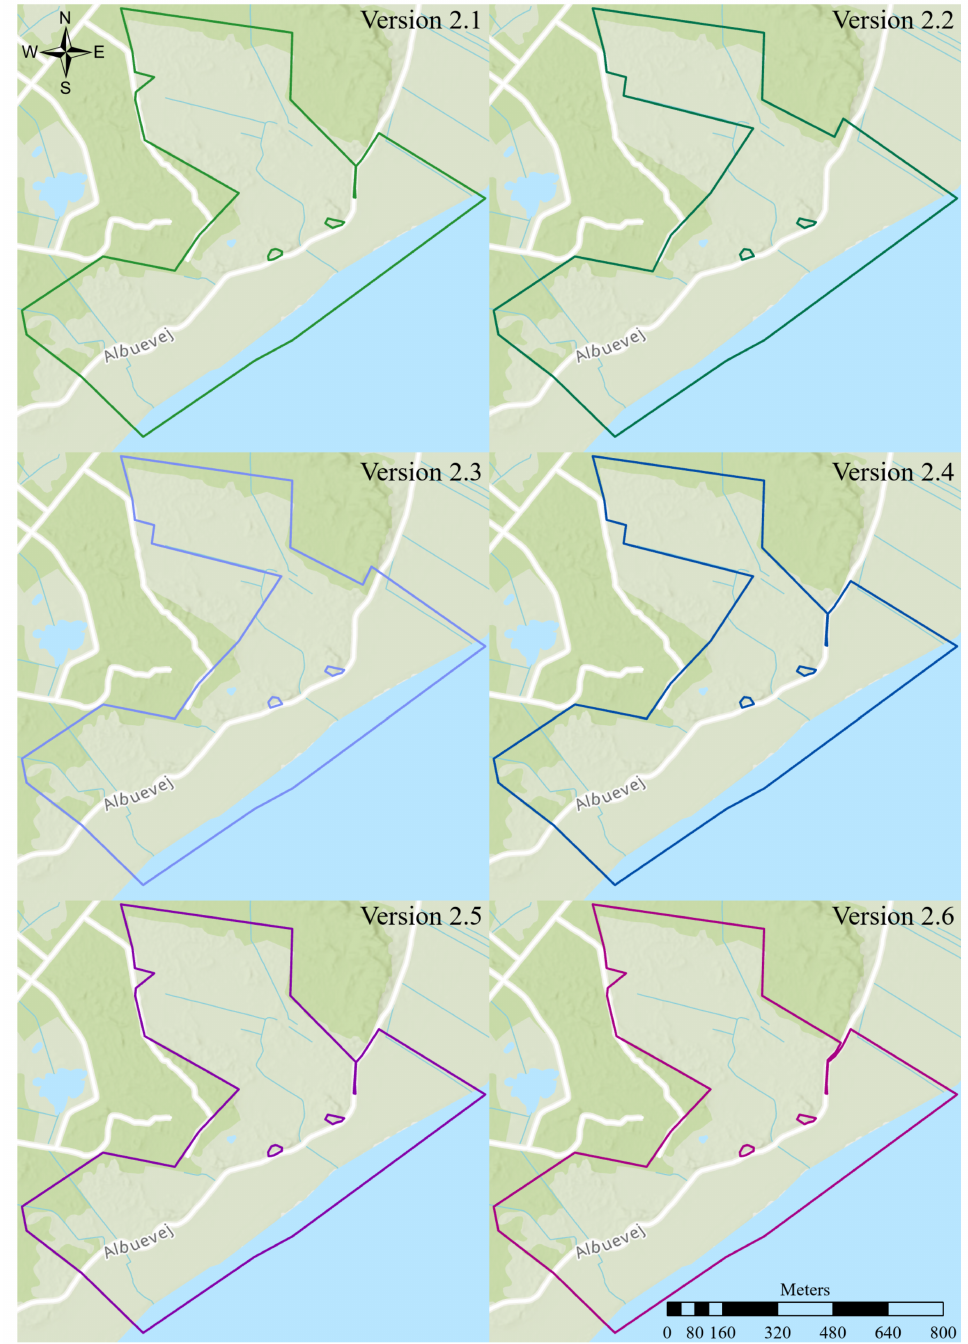
Figure A4. The virtual enclosure during period 2 . The coordinates of the lower right corner of each map frame are 8 ◦ 27 (cid:48) 59 (cid:48)(cid:48) E 55 ◦ 23 (cid:48) 50 (cid:48)(cid:48)